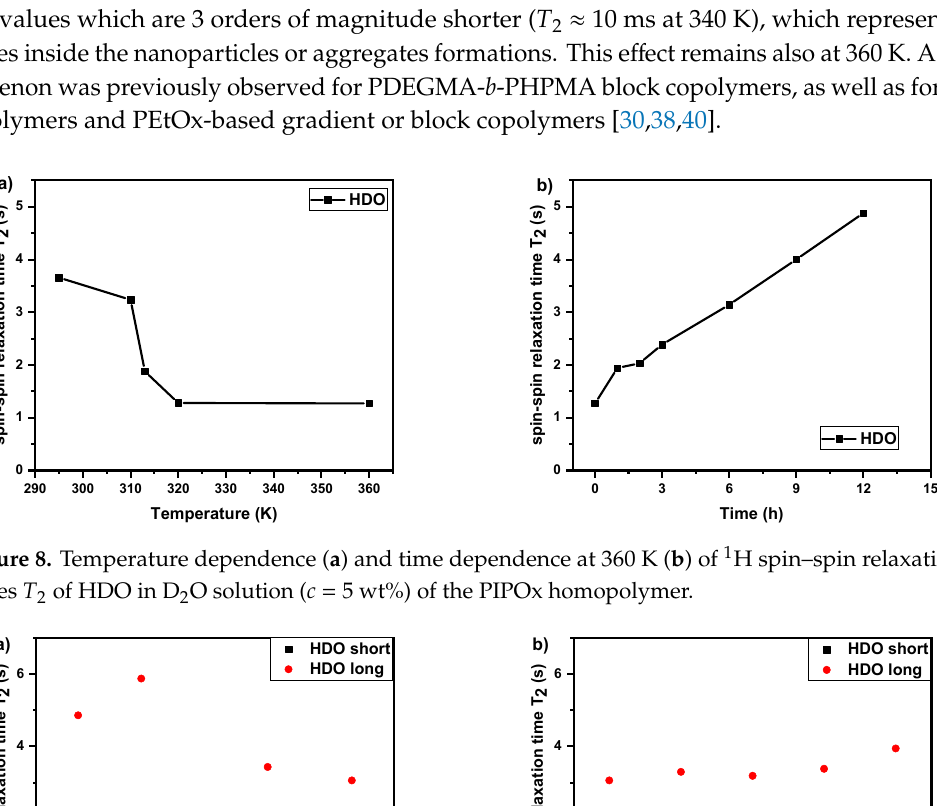
Figure 8. Temperature dependence ( a ) and time dependence at 360 K ( b ) of 1 H spin–spin relaxation times T 2 of HDO in D 2 O solution ( c = 5 wt%) of the PIPOx homopolymer.